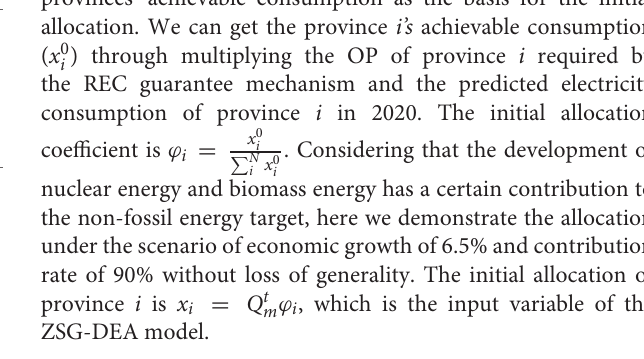
The data comes from the China Statistical Yearbook.